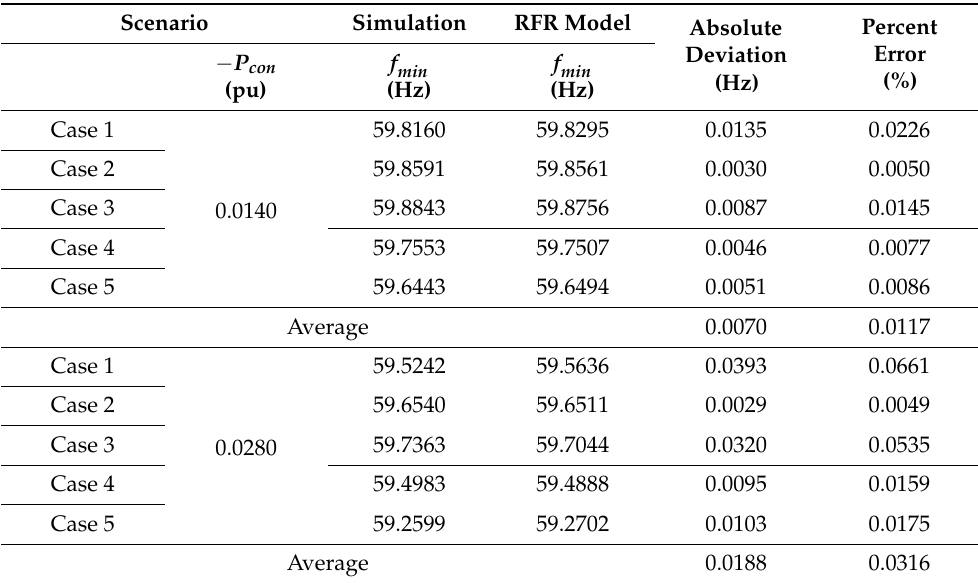
Table 2. Comparison of minimum frequency in each